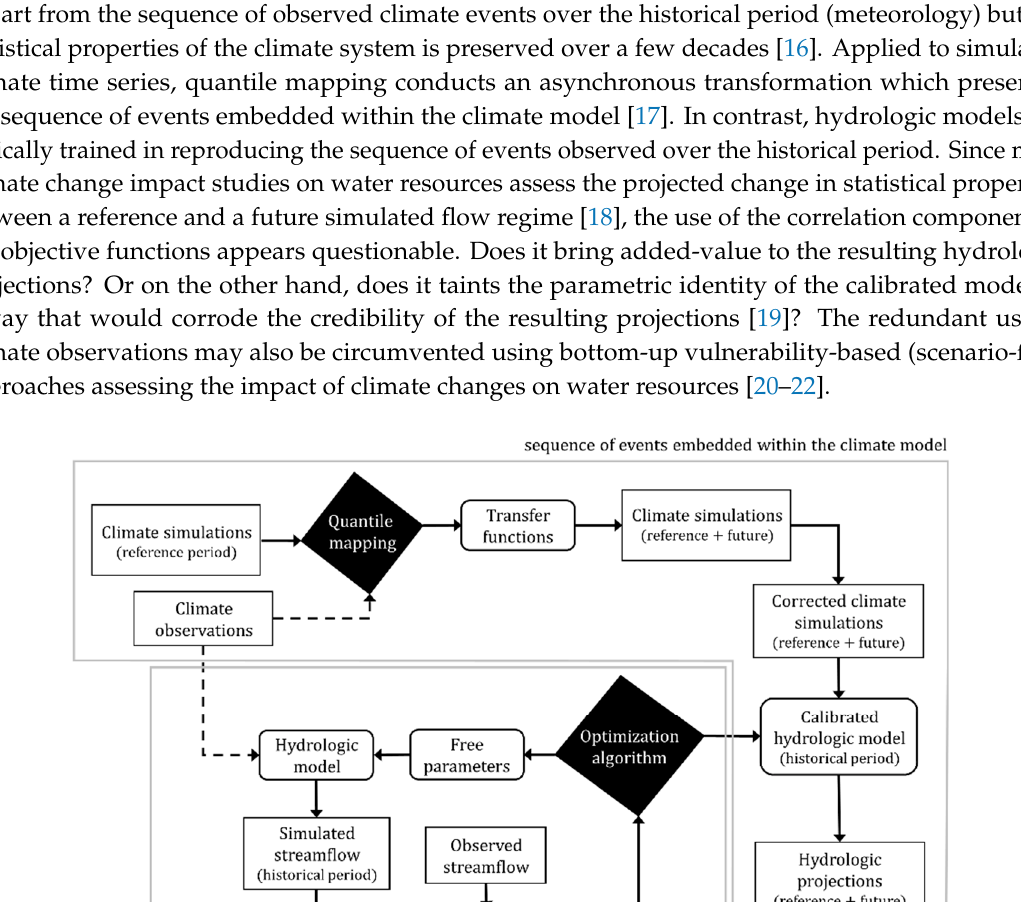
Figure 2. Alternative configuration of the hydroclimatic modeling chain. 2. Methodology The proposed step-by-step methodological framework (detailed in Appendix A) aims firstly at the testing of five exploratory AOFs in a standard modeling framework: the hydrologic model is forced with climate observations and performance is evaluated between synchronized observed and simulated streamflow values. AOFs are compared to the KGE metric over three catchments using a common split-sample test. Any AOFs presenting inappropriate performance will then be excluded from further analysis. A site-to-site variability of the simulated hydrological response is performed next to confirm the good behavior of the modeling chain before it full application to a single site. Hydrological projections are subsequently constructed from climate model simulations. Since projections are not synchronized to observations, performance is evaluated using statistical criteria excluding correlation. The evaluation of the split sample-sample test (calibration/validation periods) remains consistent with previous analyses.